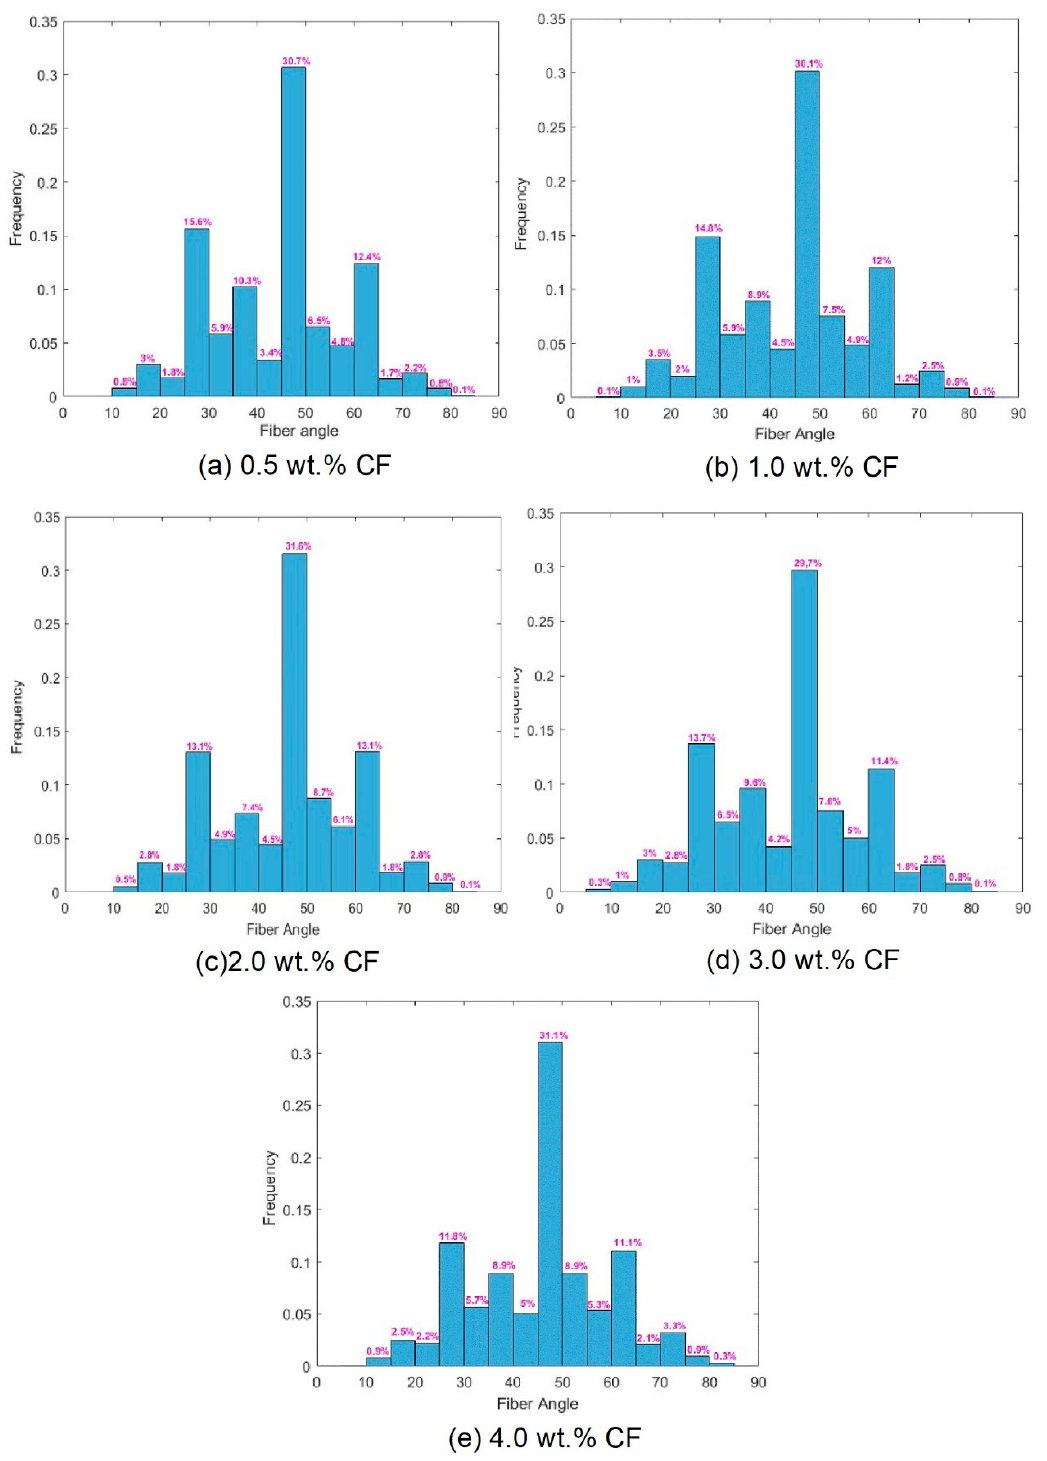
Figure 15. Histogram of the orientation angles of the carbon fibers with different contents in the contact-hardening composites: ( a ) 0.5 wt.%; ( b ) 1.0 wt.%; ( c ) 2.0 wt.%; ( d ) 3.0 wt.%; ( e ) 4.0 wt.%.